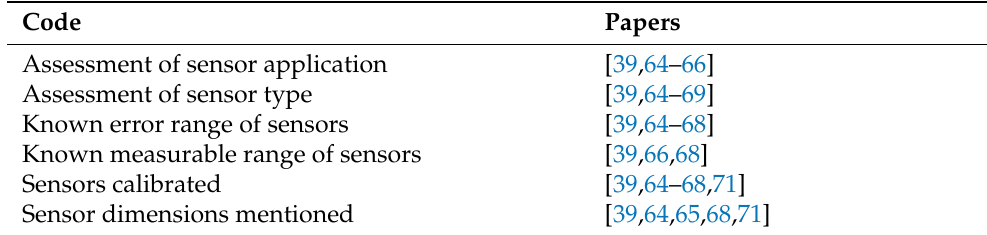
Table 7. Assessment of sensor type and use.